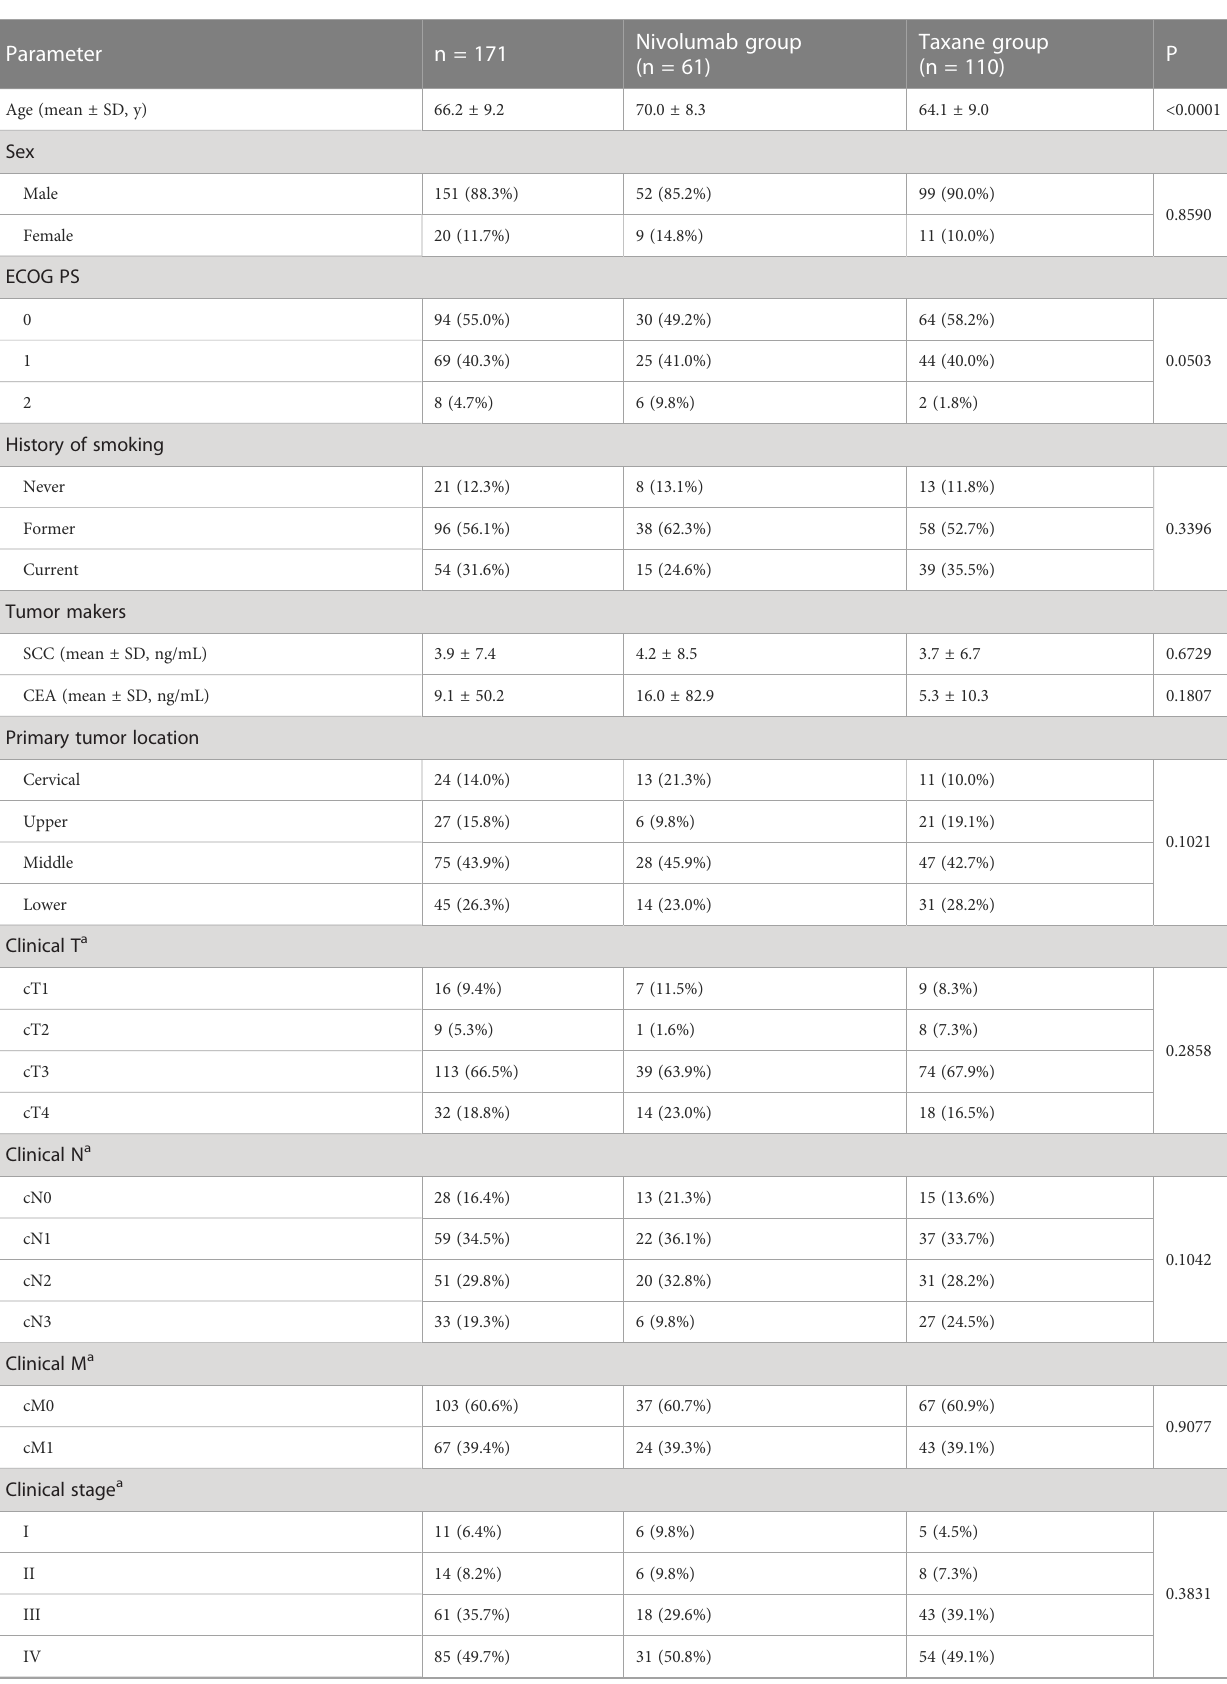
TABLE 1 Clinicopathological characteristics of patients treated with nivolumab or